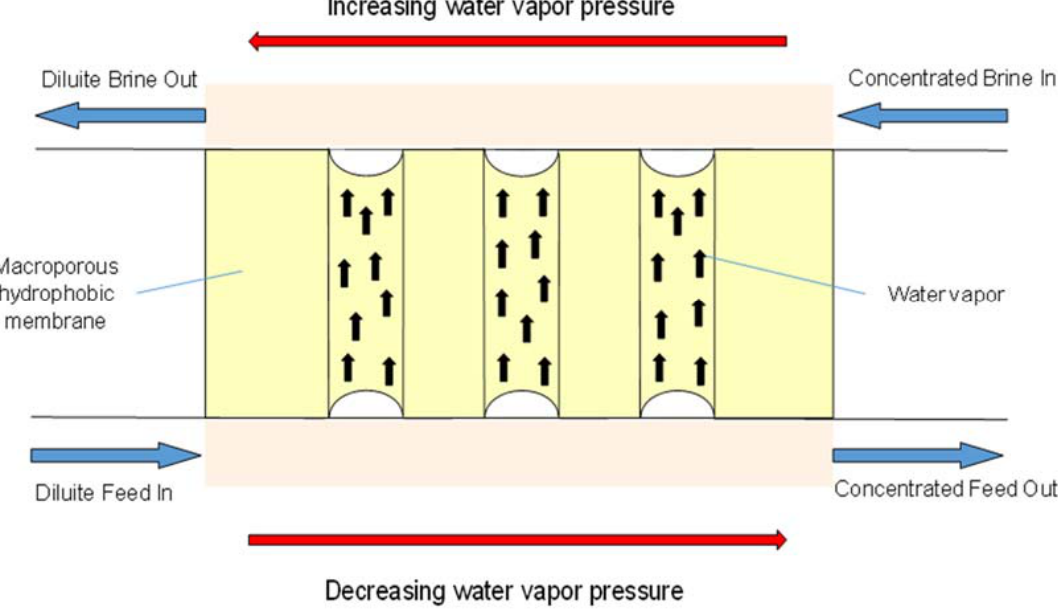
Figure 2. Osmotic distillation (OD) process. Scheme of water vapors transport through the membrane from the feed solution to the stripping solution.